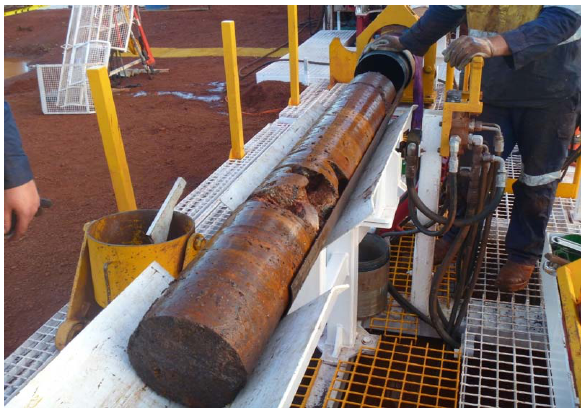
Figure 2. Eight ‐ inch (200 mm) large diameter diamond drill core (after [83]). Figure 2. Eight-inch (200 mm) large diameter diamond drill core (after [83]).